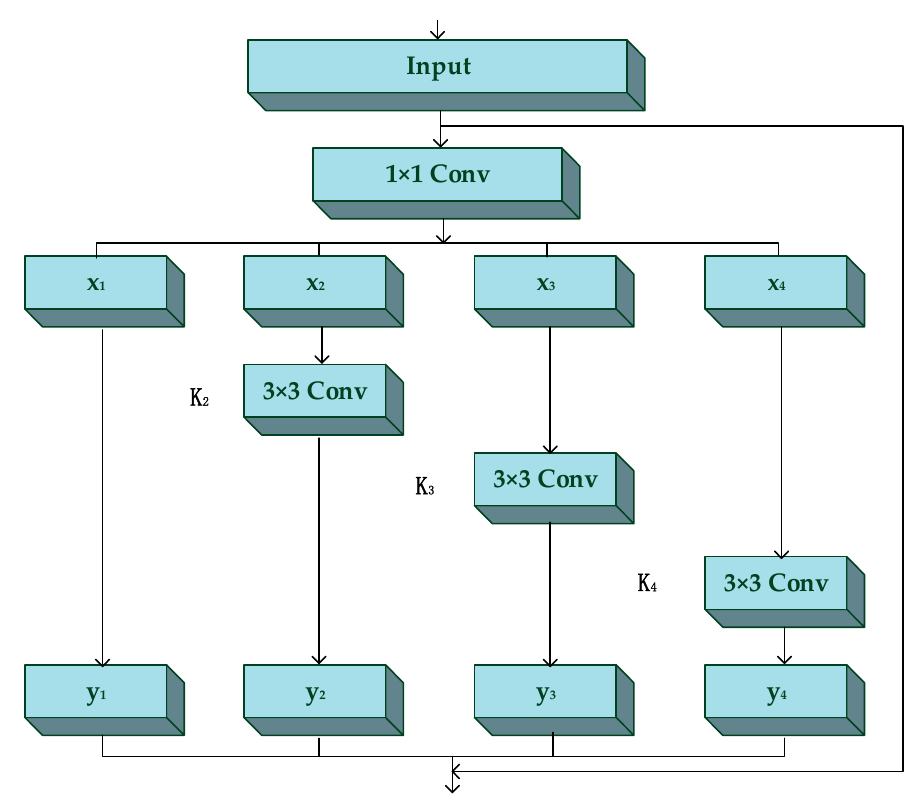
Figure 3 . The structure of the Res2 unit . Figure 3. The structure of the Res2